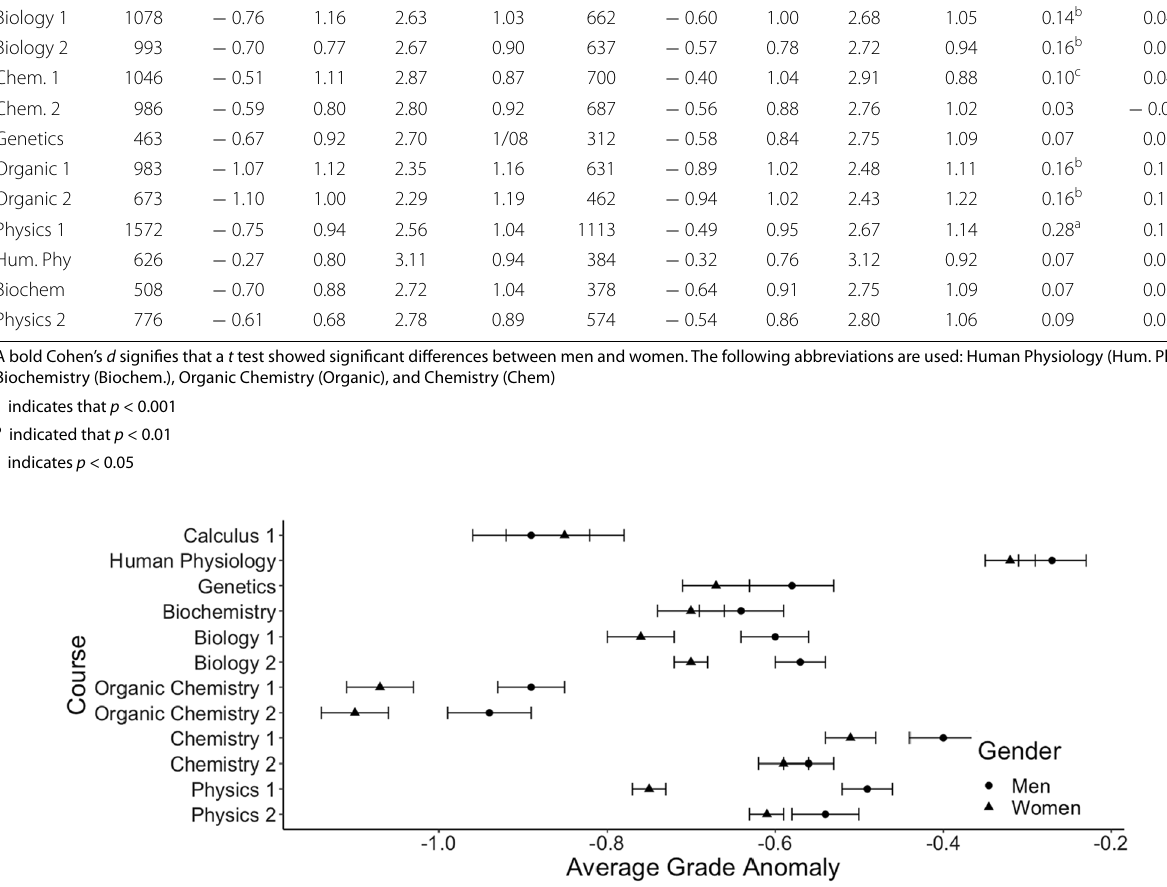
Fig. 2 Average grade anomalies (AGAs) for each course of interest, by gender. The error bars represent standard